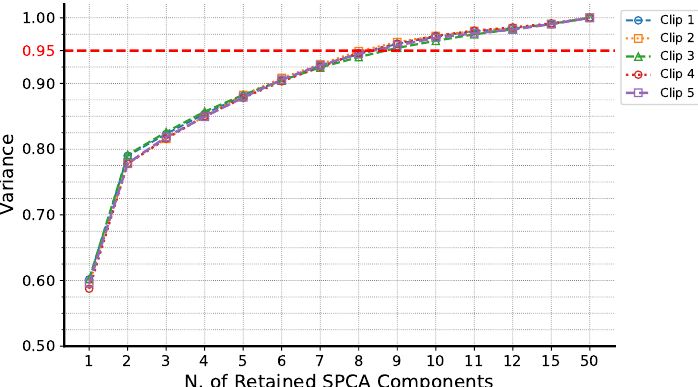
Figure 8. Variances associated to the SPCA directions for each of the five clips in the UserWGaze dataset. Notably, the curves follow a similar trend. As highlighted by a red dashed horizontal line, the 95% threshold criterion was satisfied when selecting at least 9